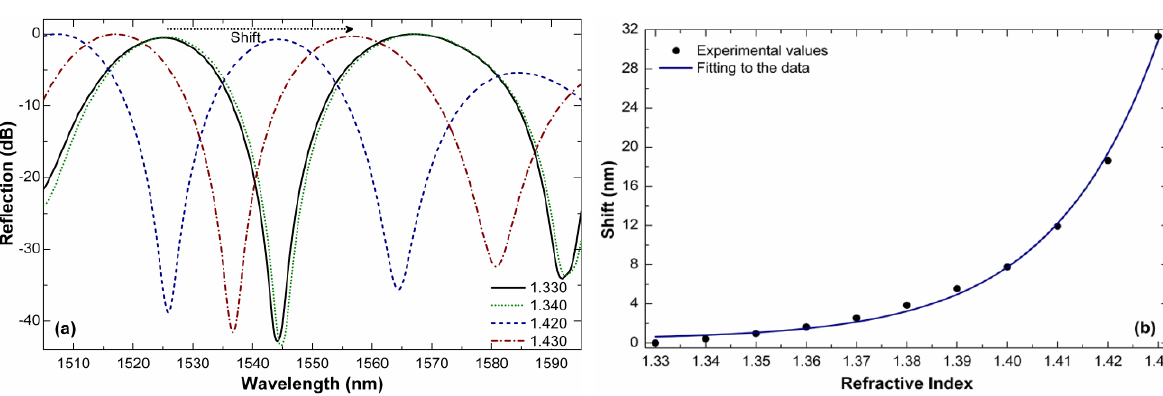
Figure 4. ( a ) Interference pattern of a 12 mm-long interferometer immersed in different indices. ( b ) Corresponding interference pattern shift versus RI. The measurements were carried out at room temperature with fluctuations on the order of 2